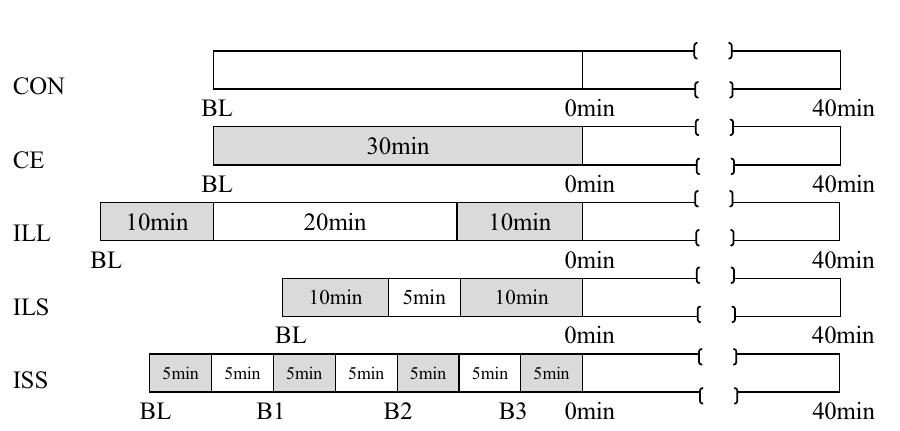
Figure 1. Study protocols for exercise, rest interval, recovery and measurements in five trials: non-exercise control trial (CON), high-volume continuous exercise trial (CE, one 30-min bout), low-volume intermittent exercise of long bouts with long interval (ILL, two 10-min bouts separated by 20-min interval), intermittent exercise of long bouts with short interval (ILS, two 10-min bouts separated by 5-min interval), and intermittent exercise of short bouts with short interval (ISS, four 5-min bouts separated by 5-min intervals). Time points of measurements were baseline (BL), immediately (0 min), and 40 min after exercise in CE, ILL, ILS and ISS